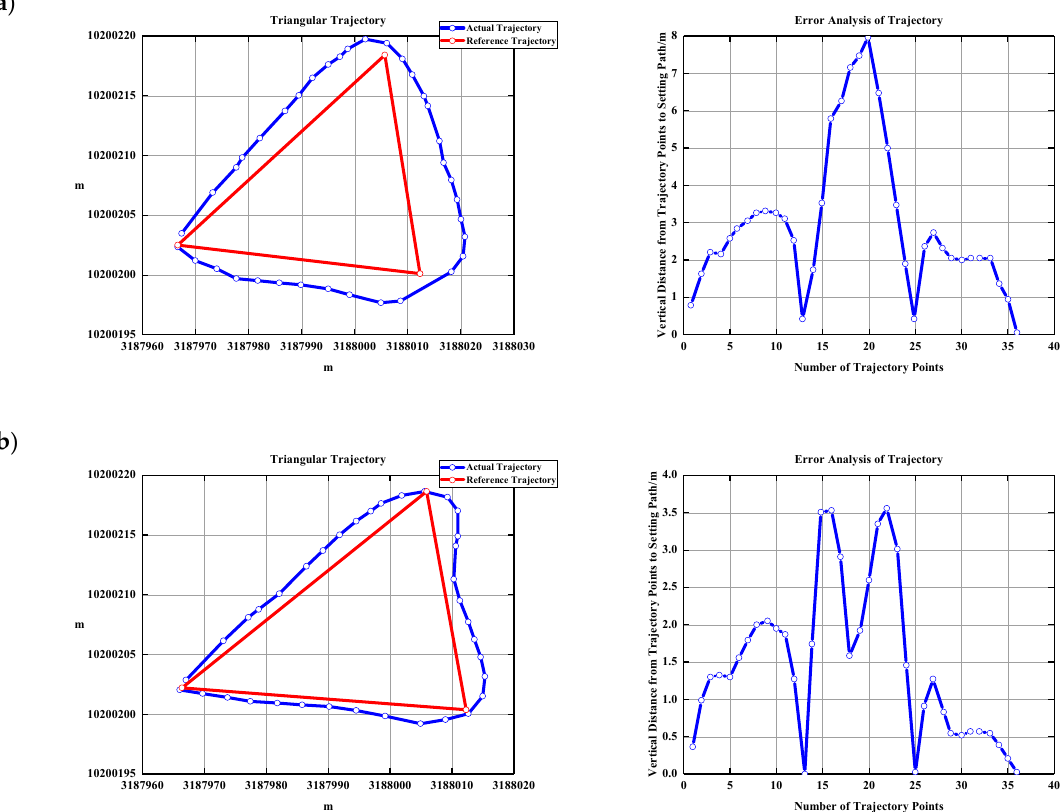
Figure 15. Triangle path test and error analysis (( a ): before improvement; ( b ): after improvement). Square Path Test